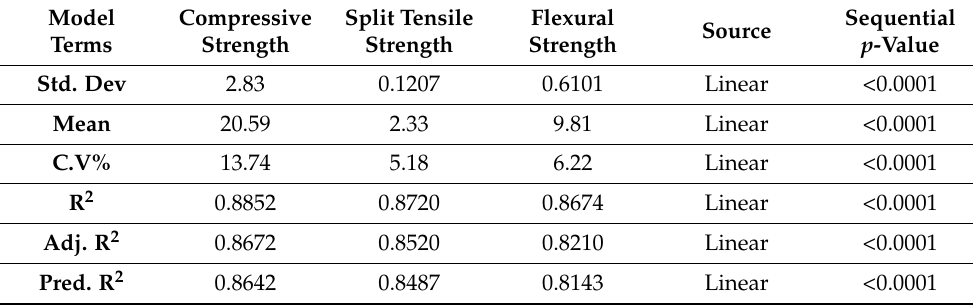
Table 7. Models (cid:48)